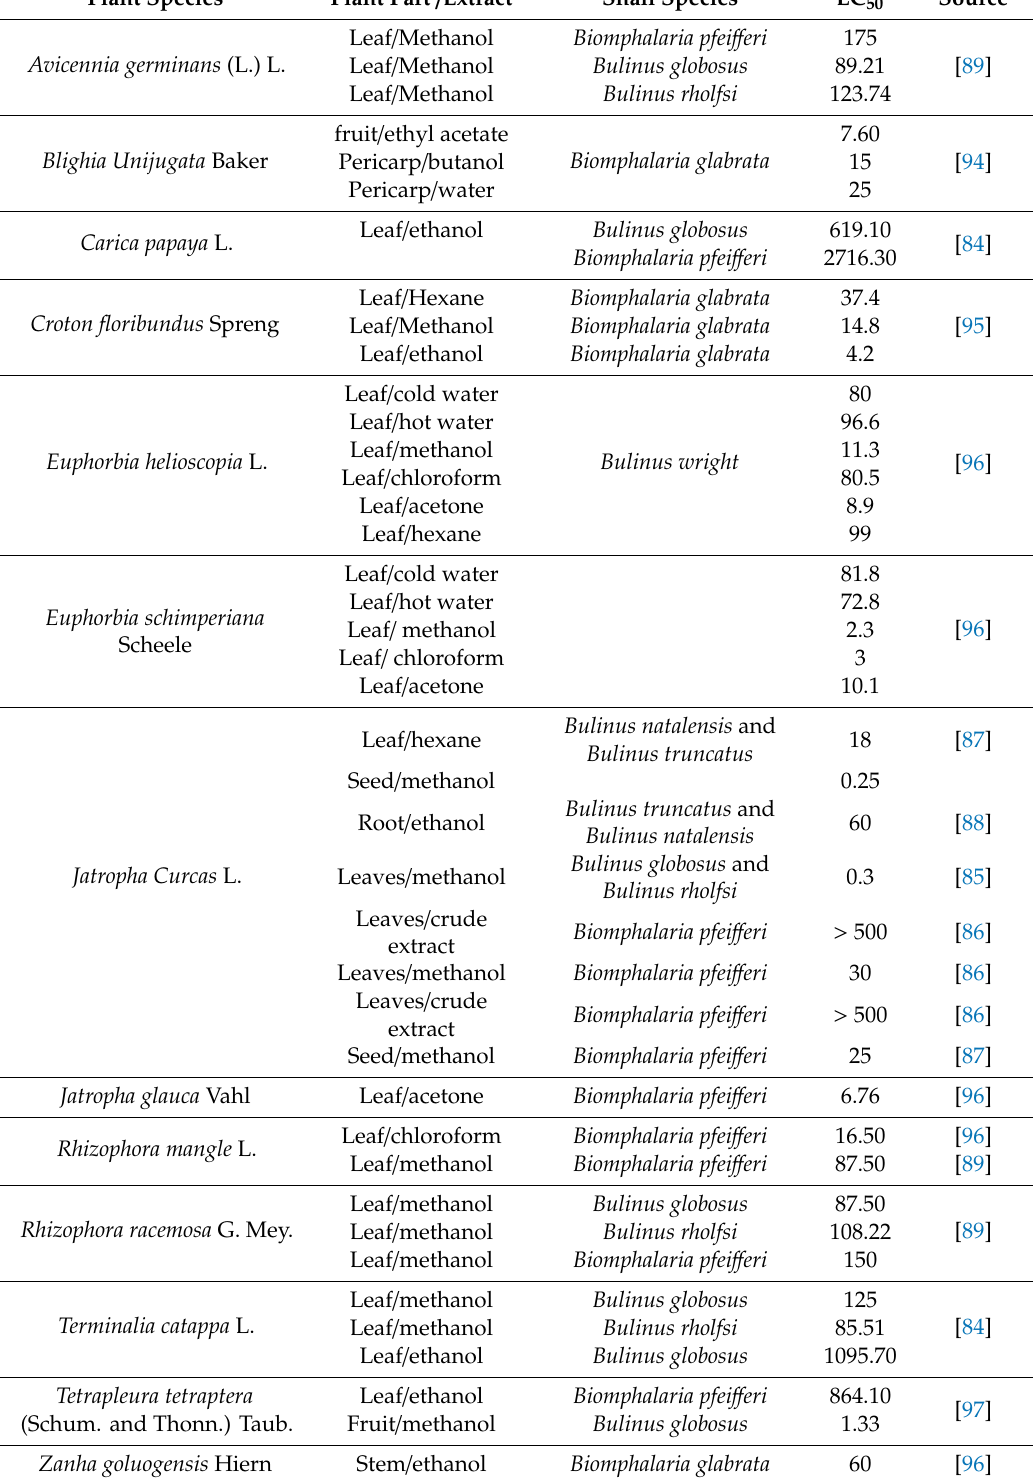
Table 4. Scientific studies of African plant species with molluscicidal activity. Plant